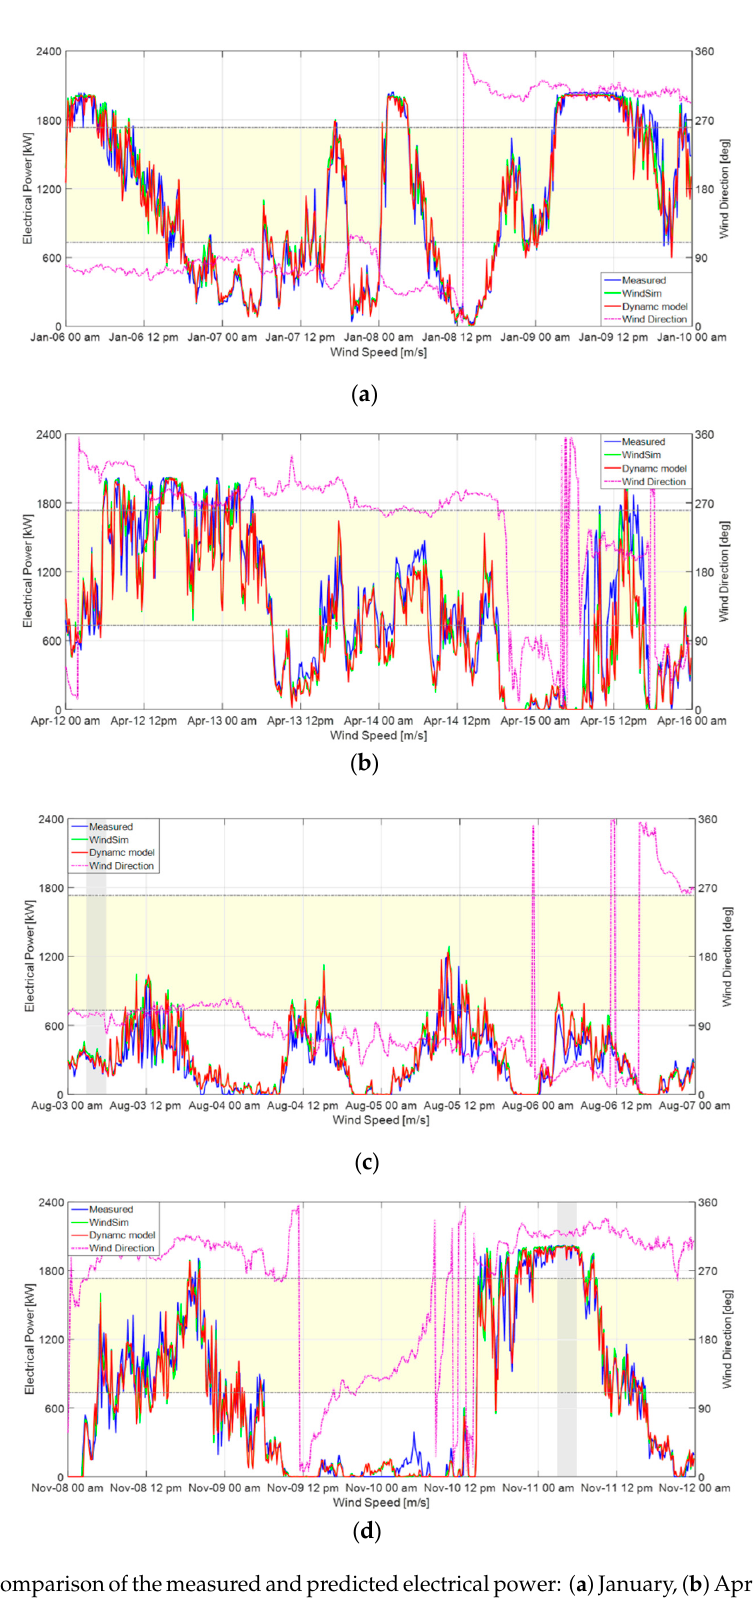
Figure 10. Comparison of the measured and predicted electrical power: ( a ) January, ( b ) April, ( c ) August, ( d ) November.